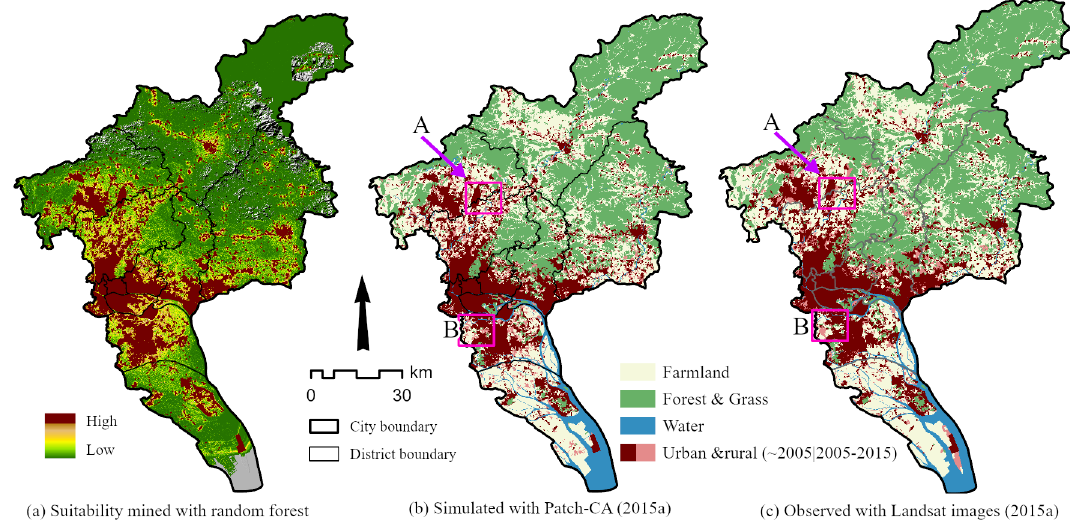
Figure 6. Simulation accuracy analysis: ( a ) suitability mined with random forest; ( b ) urban growth scenario in 2015 simulated with Patch-CA; ( c ) urban growth pattern in 2015 observed with Landsat images).